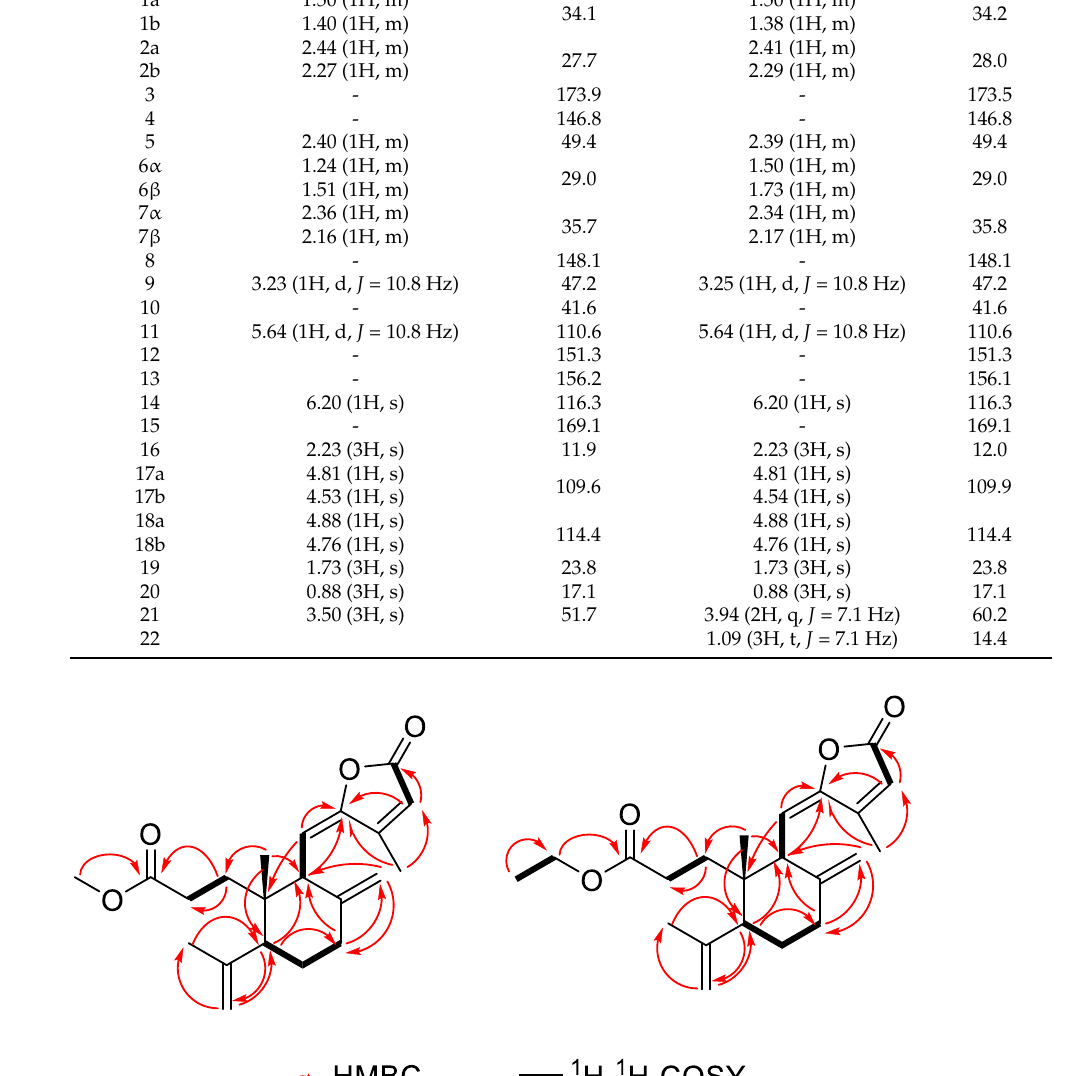
Figure 3. Key NOESY correlations of 1 . 2.2. NO Inhibitory Activities NO was considered as a key inflammatory mediator that may be helpful to treat in- flammation. RAW264.7 is derived from Abelson murine leukemia virus – induced tumor cells, which have a strong ability to phagocytize antigens and play key roles in inflamma- tory, immune, and phagocytic responses. At present, the anti-inflammatory activity of natural products using LPS-induced RAW264.7 macrophages as screening model has been widely used. Some research evidenced that such diterpenoids showed NO inhibitory activity, so compounds 1 – 3 were assayed for their NO inhibitory effects in RAW 264.7 cells. Compounds 1 – 3 inhibited LPS-induced NO production in RAW 264.7 cells with IC 50 values of 34.43 ± 1.37, 29.87 ± 2.50, and 66.58 ± 2.63 µM, respectively (Figure 4).